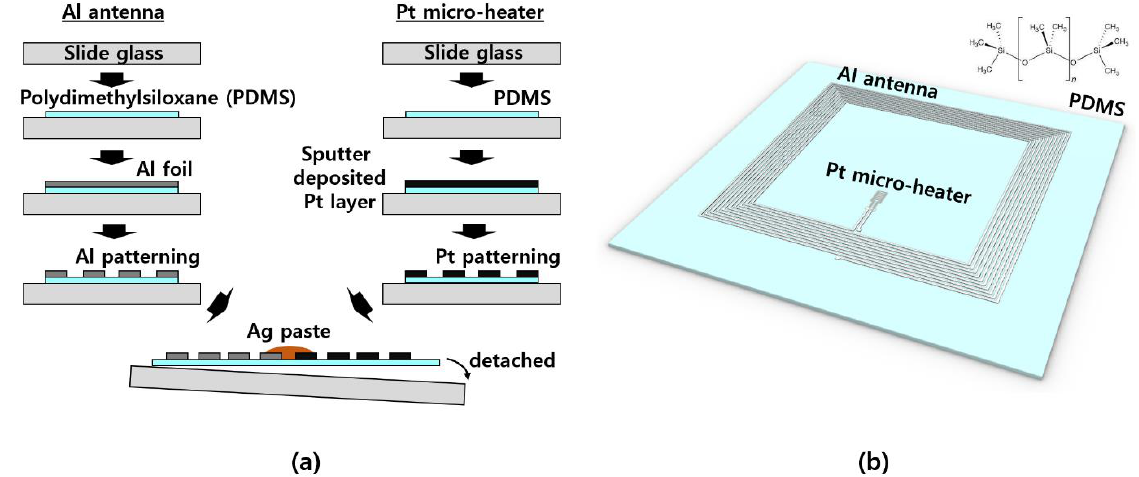
Figure 1. Schematic illustration of the fabrication procedure ( a ) and perspective view ( b ) of a wireless micro-heater device.